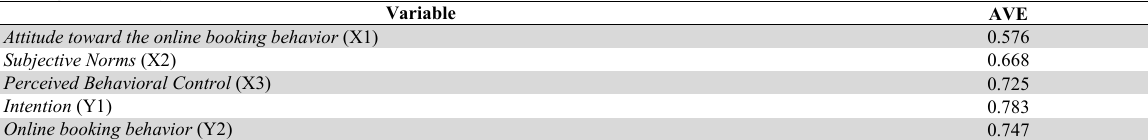
convergent validity test result